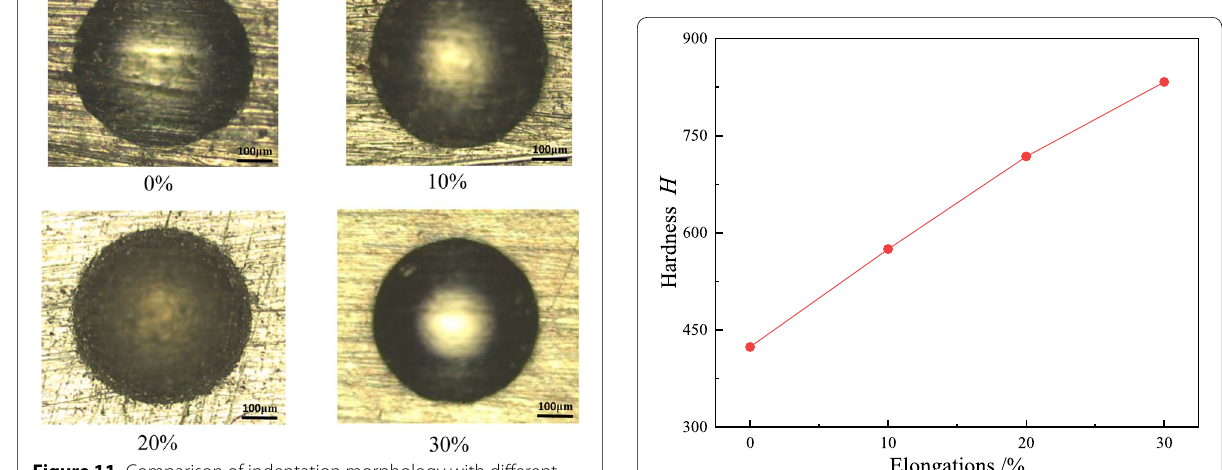
Figure 11 Comparison of indentation morphology with different elongations Figure 12 Changing law of hardness under different